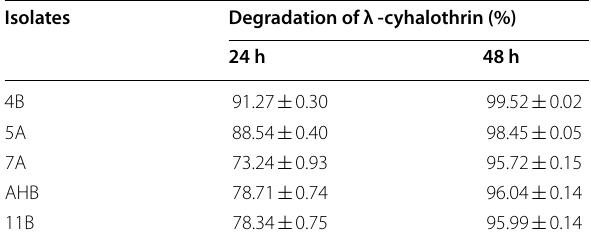
Table 2 The percentages of λ-cyhalothrin degradation in MM after incubation at 37 °C for two days